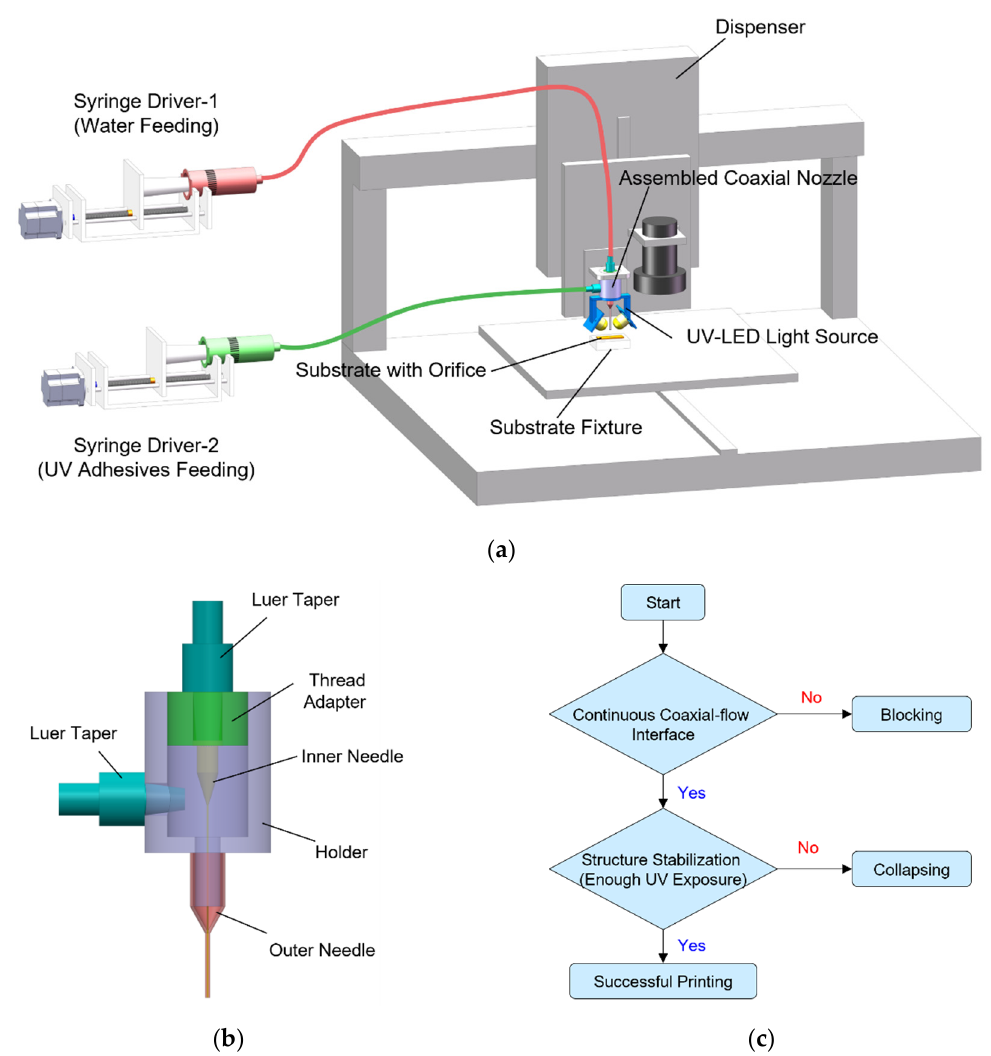
Figure 1. Experimental procedure for the fabrication of 3D-printed microfluidic connectors: ( a ) UV-assisted, coaxial 3D printing system; ( b ) design of the assembled coaxial nozzle; ( c ) flowchart of the printing strategy.